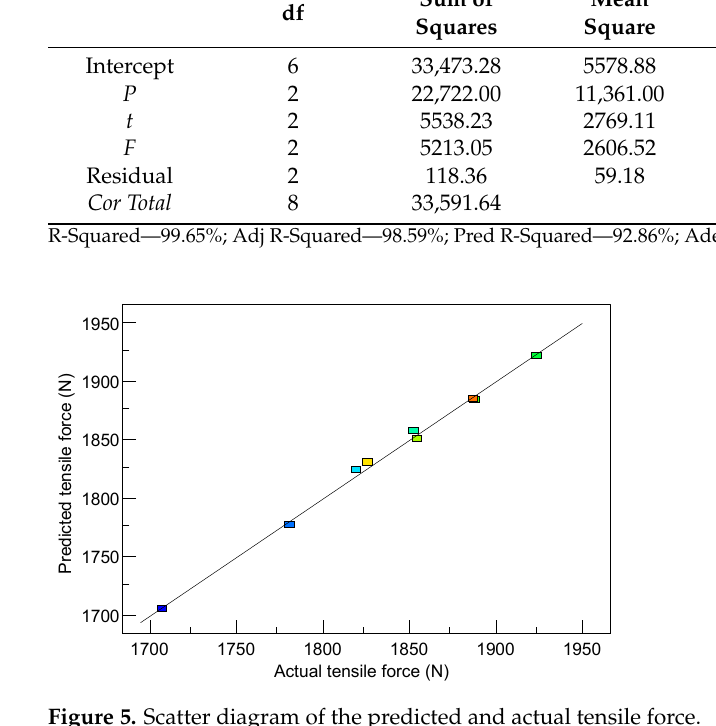
Figure 5. Scatter diagram of the predicted and actual tensile force.